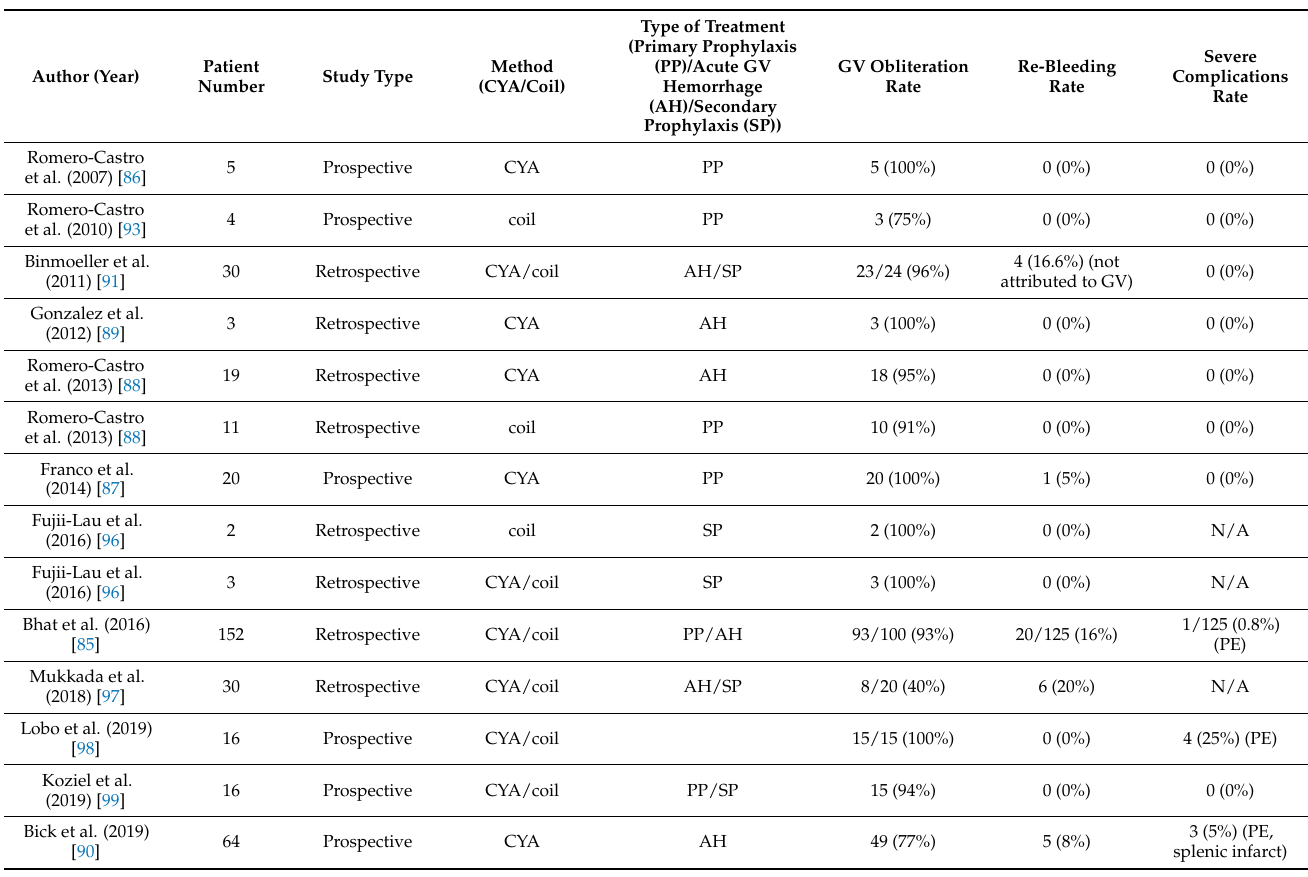
Table 2. Summary of studies reporting EUS-guided CYA/coil injection of GV for primary/secondary prophylaxis and acute GV